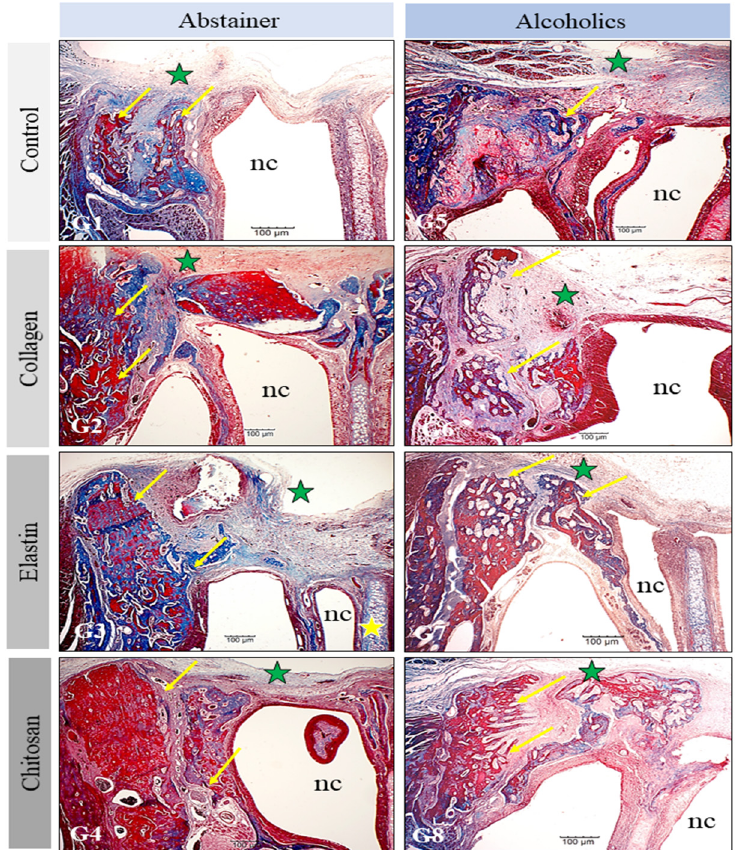
Figure 4. Histological findings in the surgical areas (green star) of the groups studied (G1–G8). The newly formed bone (arrows) originates from the margins of the defect and is more compact in the abstainer groups and more trabecular in the alcoholic groups. The nasal cavity (nc) and nasal septum (yellow star) are preserved in all groups. Bar: 100 µm.